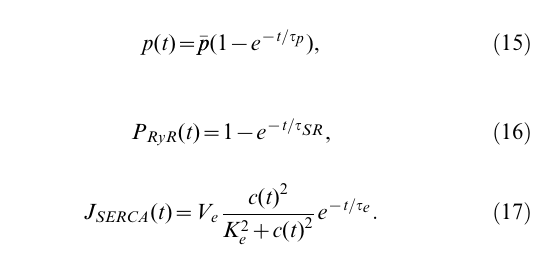
Fig. 3A-C shows representative ½ Ca 2 z (cid:2) in a human lung slice in response to a three-step experimental protocol [2]. This protocol was originally designed to clamp the